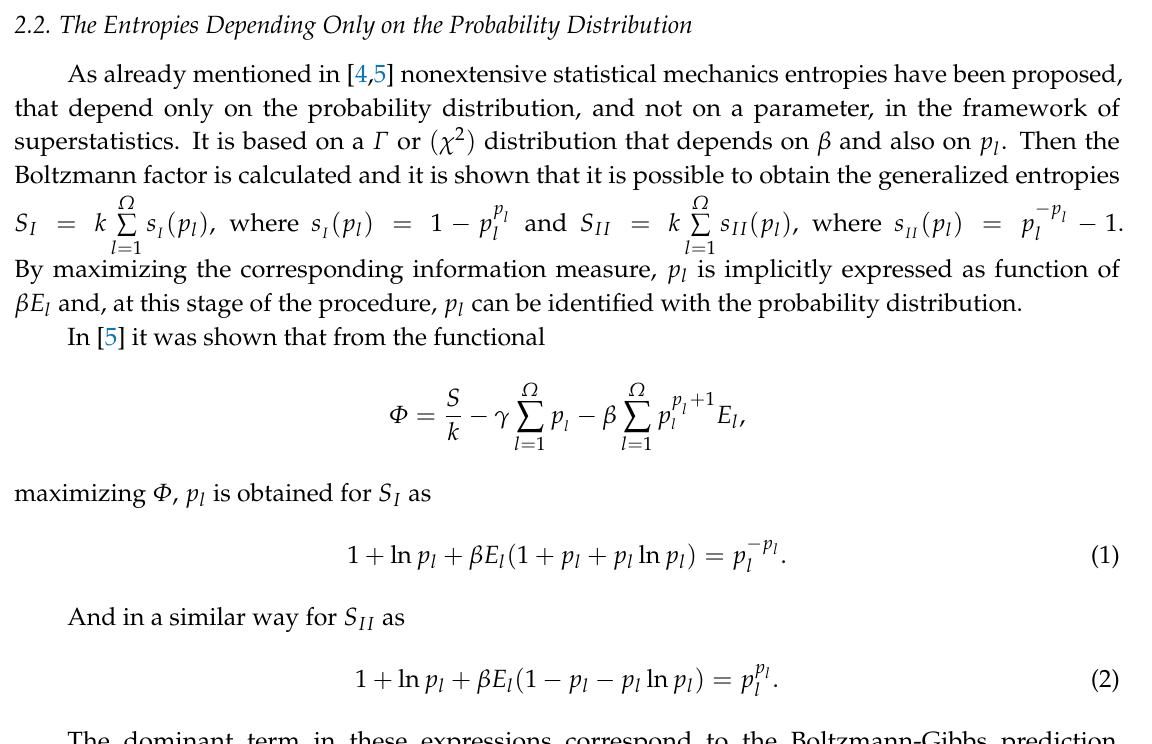
Figure 3. Comparison of Tsallis distributions (FD-Tsallis) for different values of q